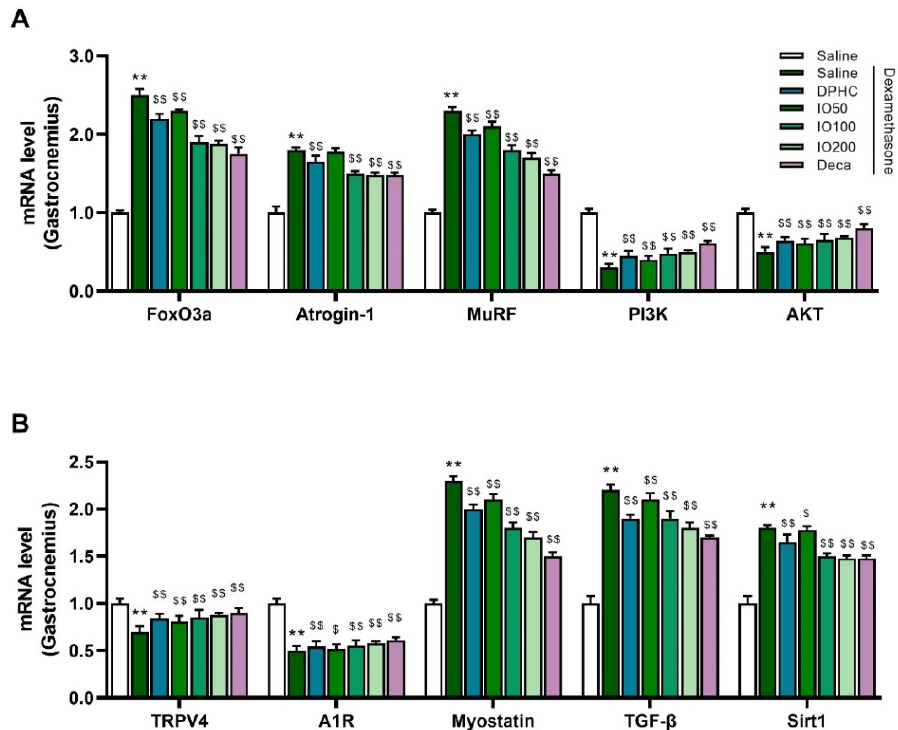
Figure 4. Levels of mRNA related to protein degradation and muscle growth in gastrocnemius muscle of DEX-treated mice displaying muscle atrophy. The panels display results for FoxO3a, Atrogin-1, MuRF, PI3K and AKT ( A ). TRPV4, A1R, Myostatin, TGF- β , and Sirt1 are aligned in ( B ). Each group was examined in n = 3 mice. All values are expressed as the mean ± standard error. Significant differences are indicated as ** p < 0.01 compared with control or $ p < 0.05, $$ p < 0.01 compared with DEX-saline (Mann–Whitney U test).